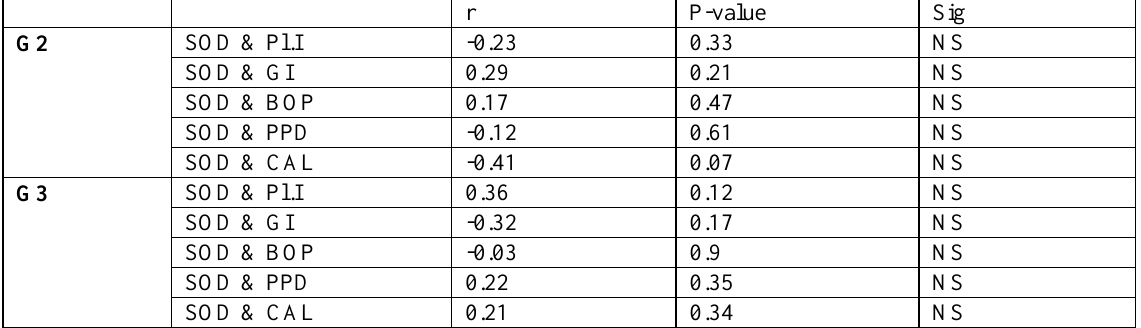
Table 5: Pearson's coefficient of correlation (r) between SOD levels (U/mL) and periodontal parameters for G2 and G3 with significant